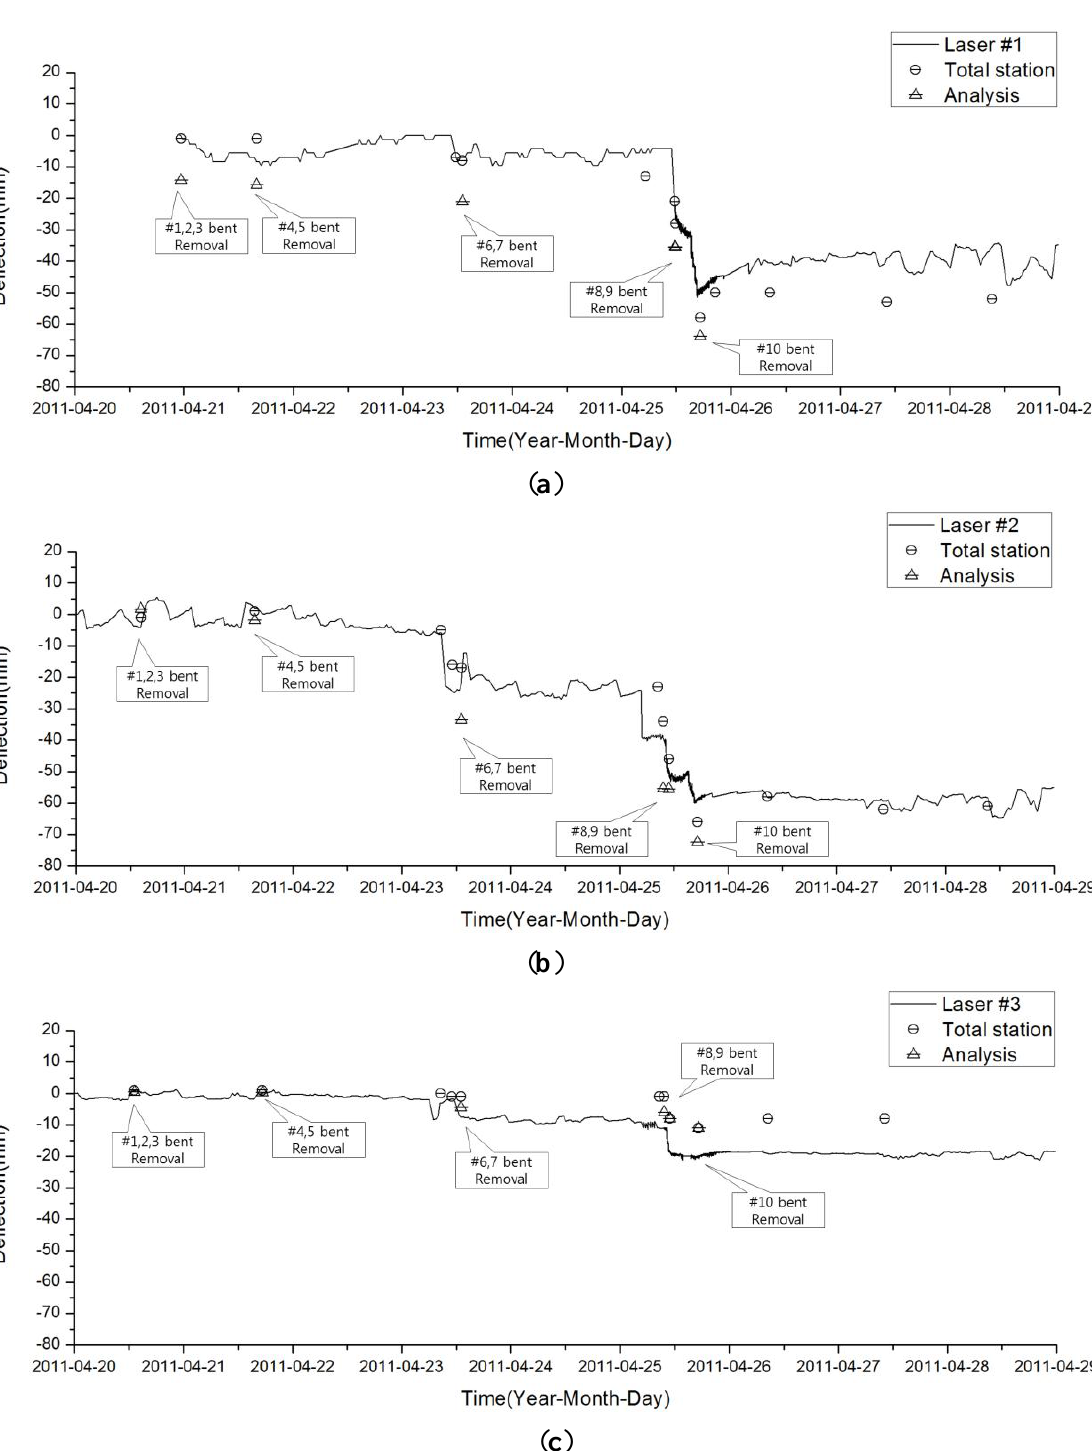
Figure 13. Variations of deflection during bent removal: ( a ) point 1, ( b ) point 2 and ( c ) point